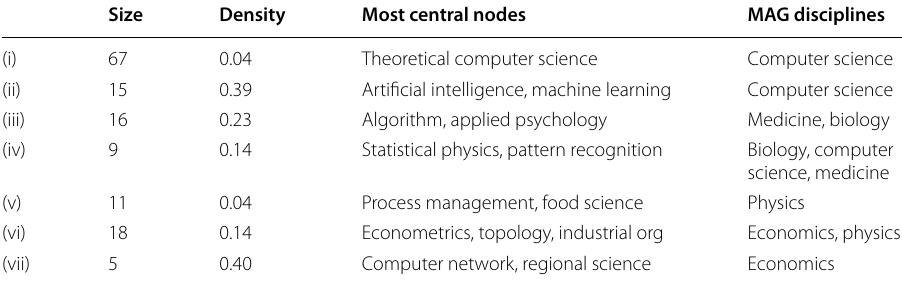
Table 2 Louvain communities in ANS-related research and their size, network density, most central topics (according to degree centrality) and the most frequent MAG disciplines that are identified in them ( ≥ 20% of